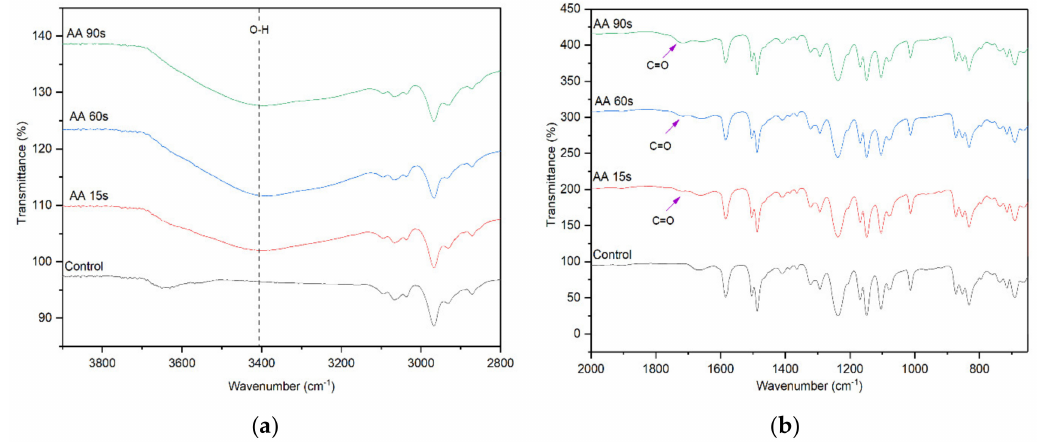
Figure 3. FTIR spectra of the control membrane and AA-modified membranes, ( a ) wavenumber of 3800–2800 cm − 1 and ( b ) wavenumber of 2000–600 cm − 1